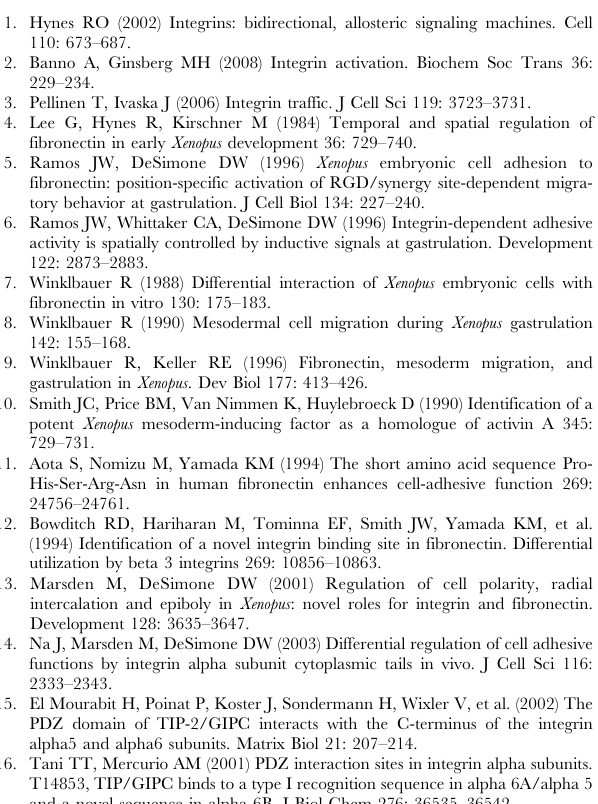
Figure S3 Immunoprecipitation of biotin labeled cell surface integrins. In the Iˆ 6 5Iˆ 2 1 immunprecipitation a cell surface protein of 30 kD co-precipitates strongly in samples adherent to FN (arrowhead). The Iˆ 6 5Iˆ 2 1 immunoprecipitation is the same as Figure 7. In the Iˆ 6 VIˆ 2 3 immunprecipitations the same 30 kD band is visible but is not specific to FN adherent cells (arrowhead). A 50kD band appears in non-adherent cells. Found at: doi:10.1371/journal.pone.0010665.s003 (0.45 MB